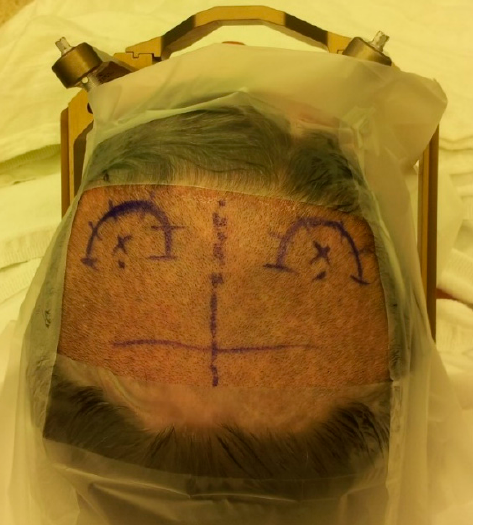
Figure 9. The site of the two semicircular incisions marked on both sides of the midline; with the two burr holes’ positions marked with an X.